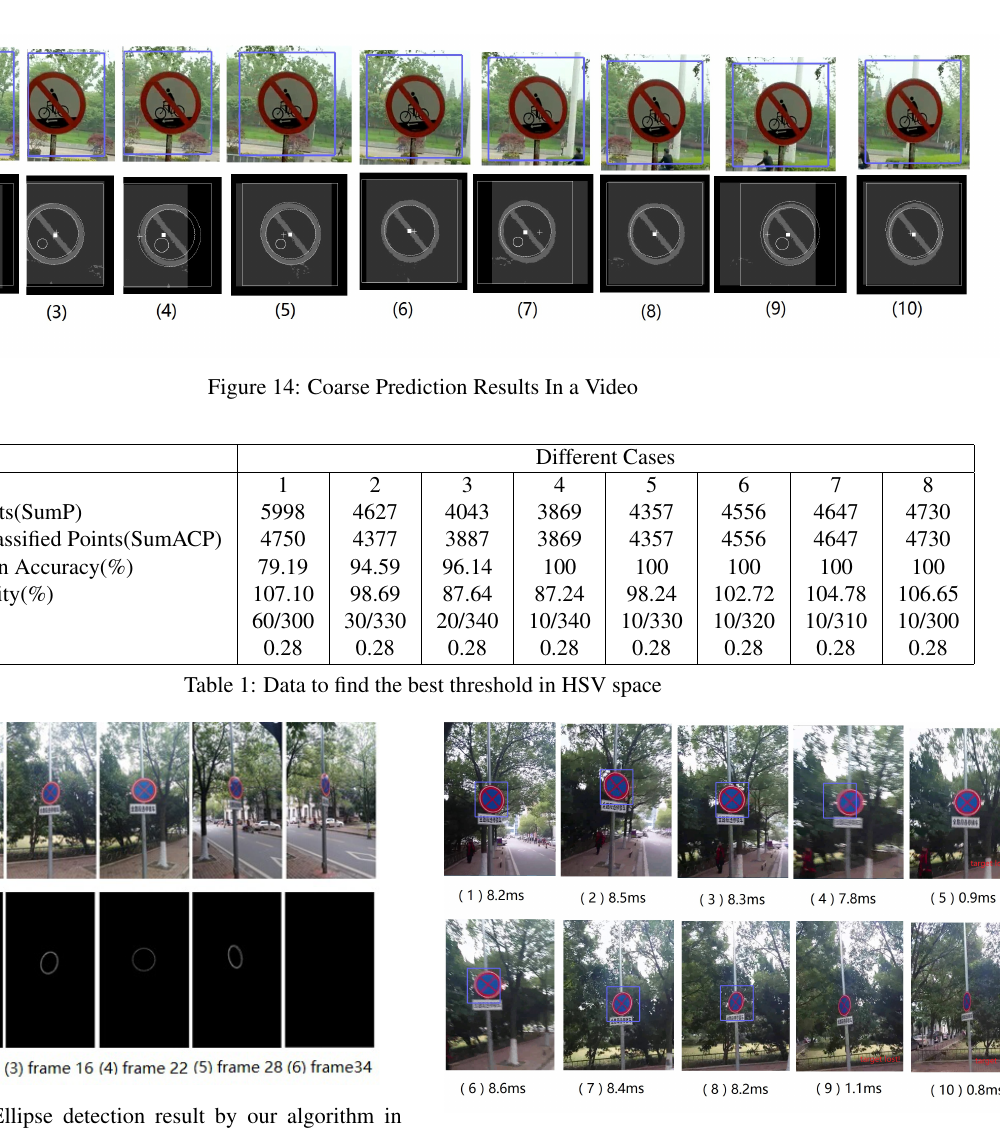
Figure 21: Several frames in second